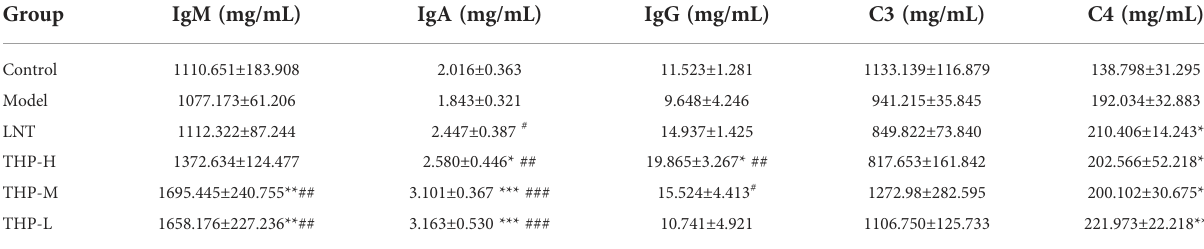
TABLE 1 Effects of THP on immunoglobulin and complement in